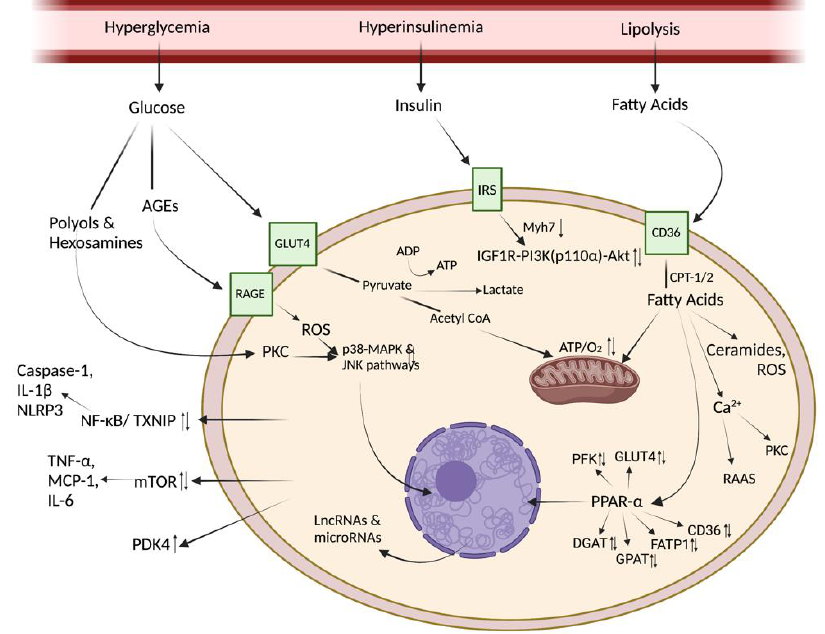
Figure 1. Molecular mechanisms inducing diabetic cardiomyopathy. Elevated levels of plasma glucose and insulin in T2DM and increased lipolysis of fatty acids activates a number of adverse signaling pathways in cardiomyocytes. (Image created with BioRender.com).